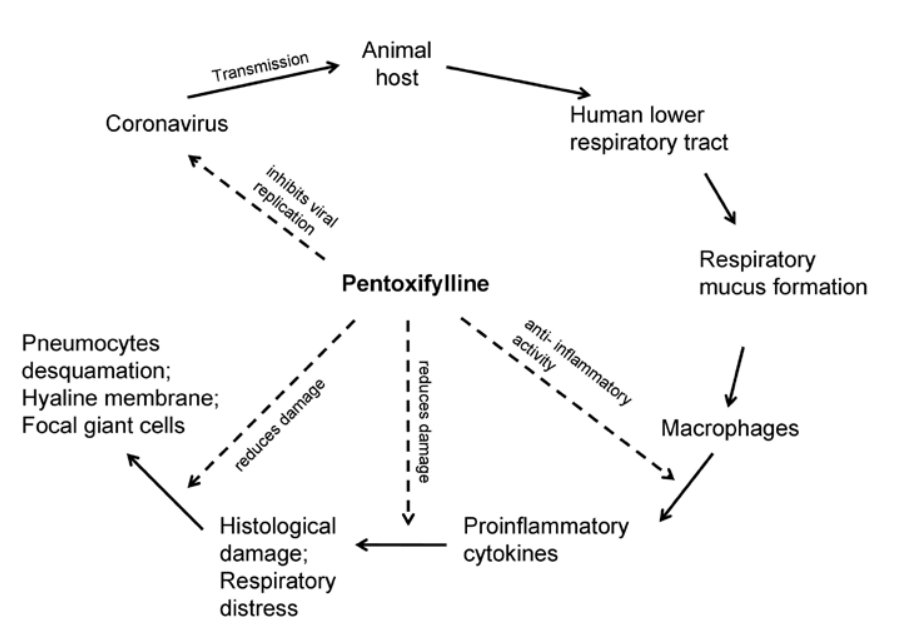
Fig. 2. Coronavirus cycle and the hypothetical activity of